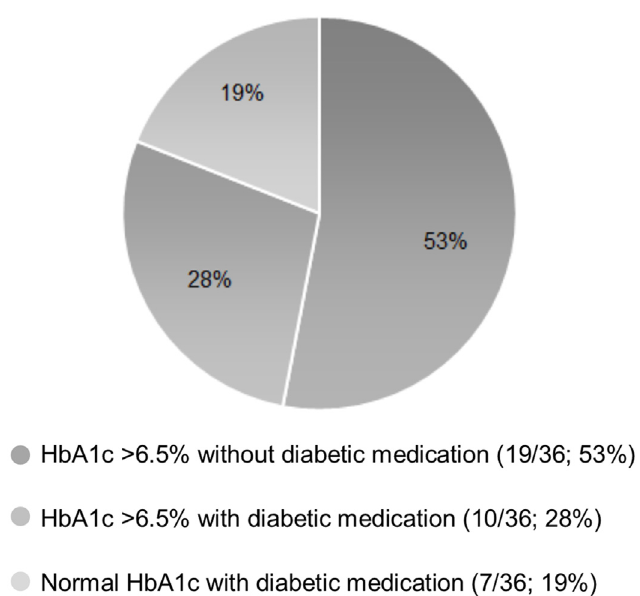
Fig 2. Diabetes Control in HIV-positive patients (N = 36). Included subjects from the cohort of 903 HIV- positive patients: 36 patients, previously diagnosed with diabetes or in whom a raised HbA1c was measured. Raised HbA1c = HbA1c >